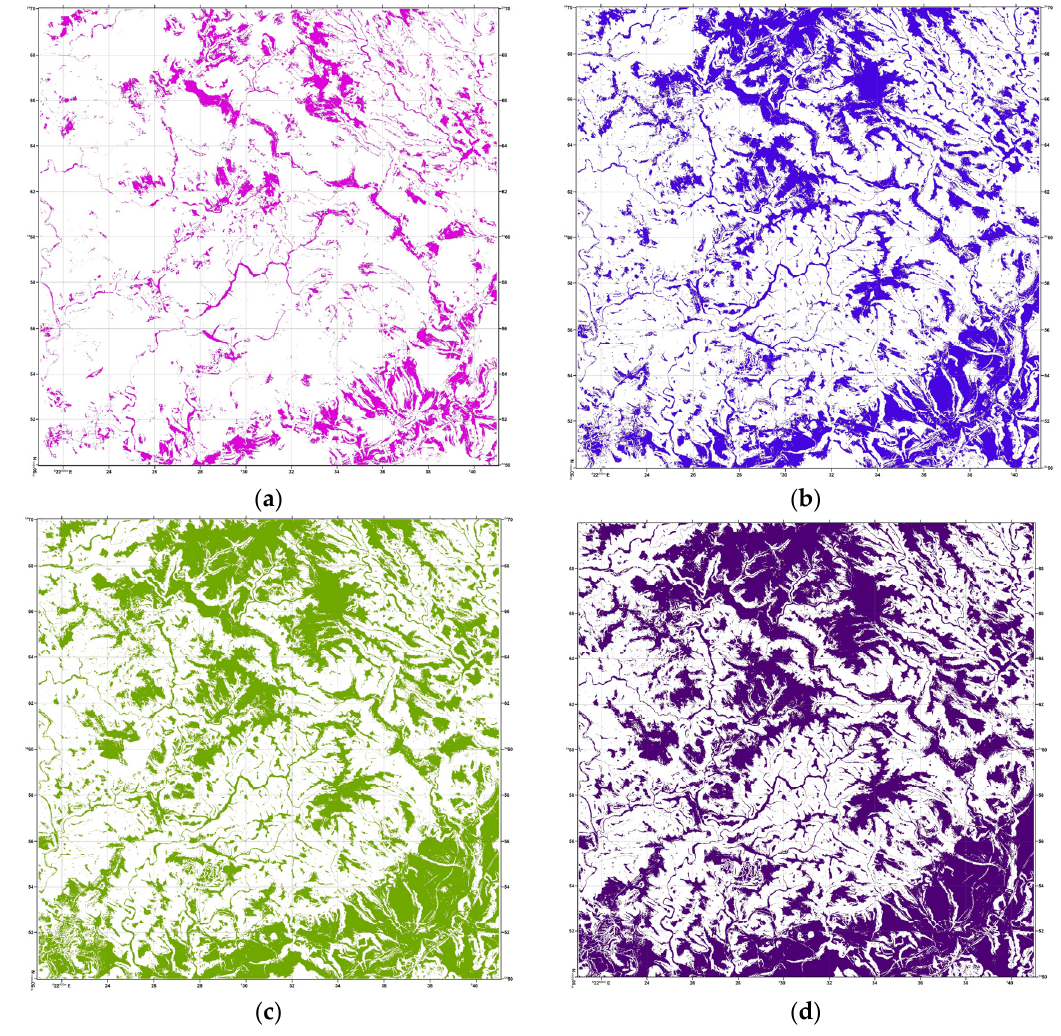
Figure 8. Distribution of the intersection of the same values of suitability for DS deployment in the AOI area for values ( a ) ≥ 9, ( b ) ≥ 8, ( c ) ≥ 7, ( d ) ≥